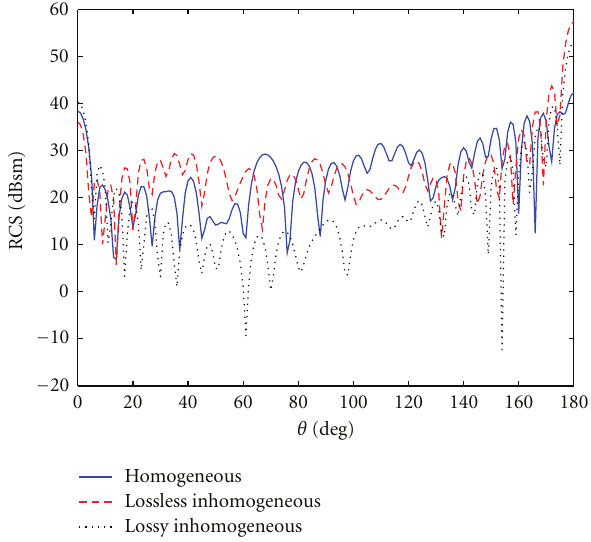
Figure 7: Bistatic RCS of the large dielectric brick with θ inc = 0 ◦ , ϕ = 0 ◦ at 0.3 inc